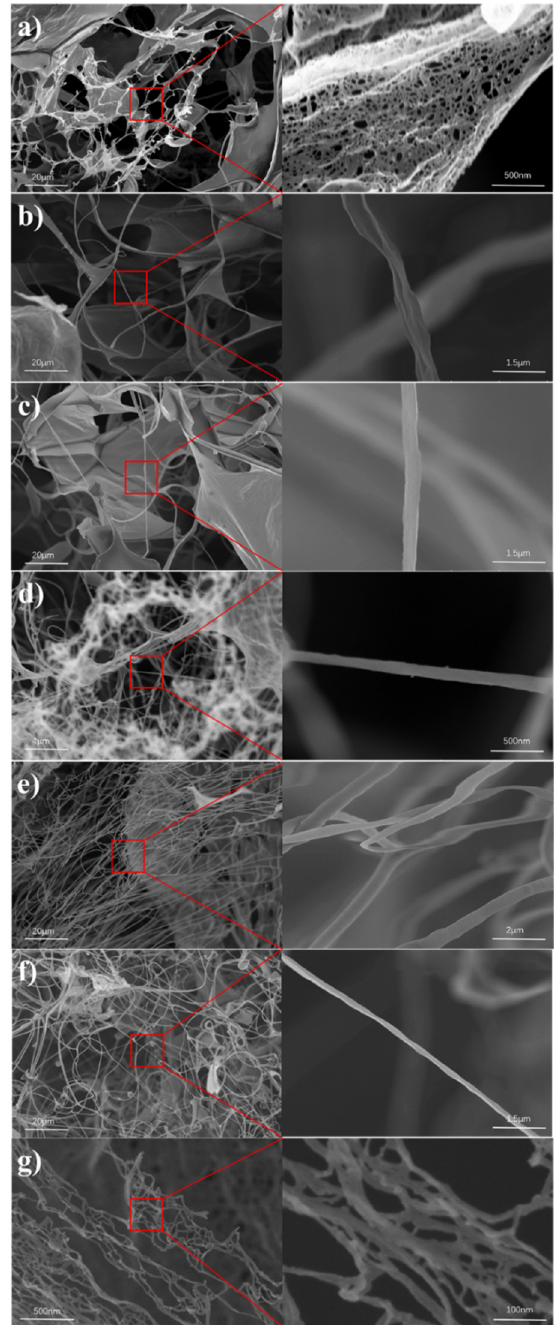
Figure 1. SEM images of the CNFs. ( a ) WCNF, ( b ) WCNF1, ( c ) WCNF2, ( d ) BCNF, ( e ) BCNF1, ( f ) BCNF2, ( g ) PCNF. ( f ) BCNF2, ( g )